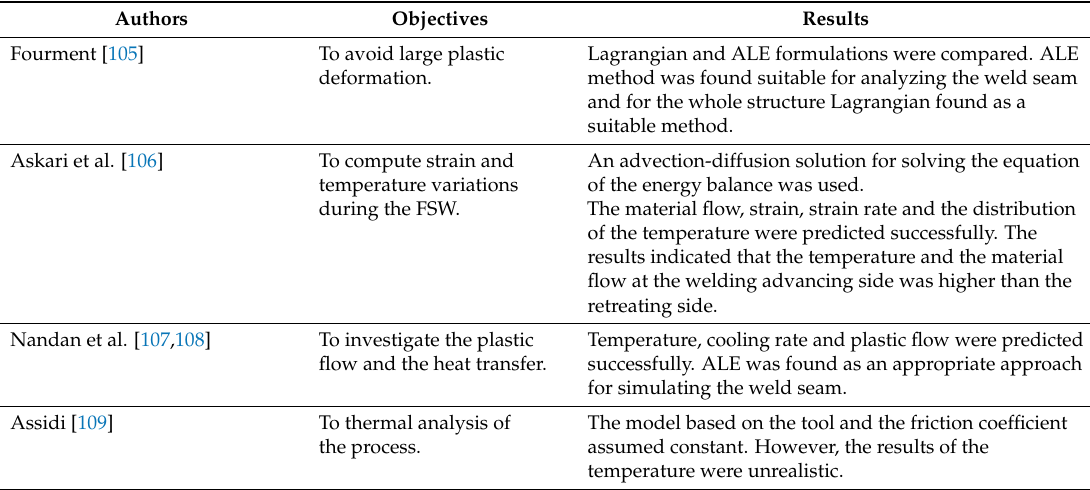
Table 4. Summary and the outlook of the research which was used ALE (arbitrary Lagrangian– Eulerian)